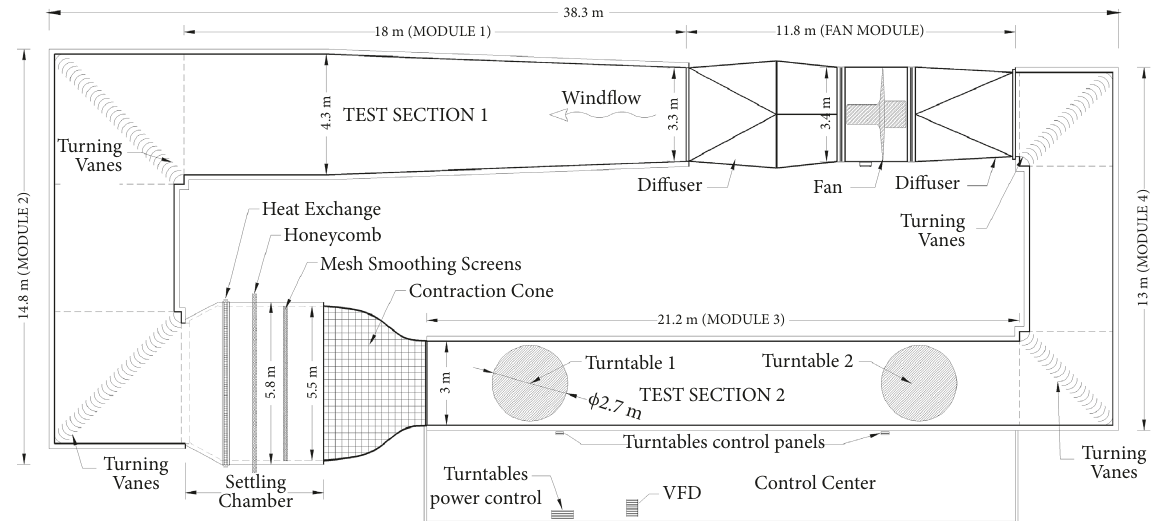
Figure 4: Sketch of the boundary layer wind tunnel of institute of engineering,